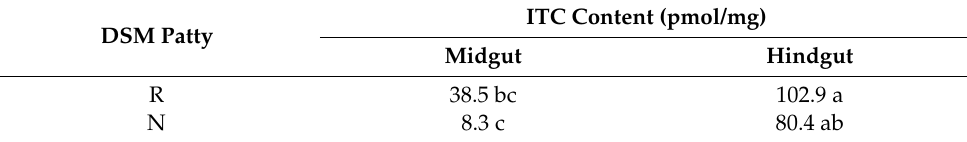
Table 3. The total ITC content of midgut and hindgut tissues of the bees fed on R and N for 28 days. ITC content is expressed as pmol/mg of the gut tissue. Mean values ( n = 5) are shown. Statistical differences between the ITC content means are indicated by different lowercase letters ( p < 0.05, LSD test).